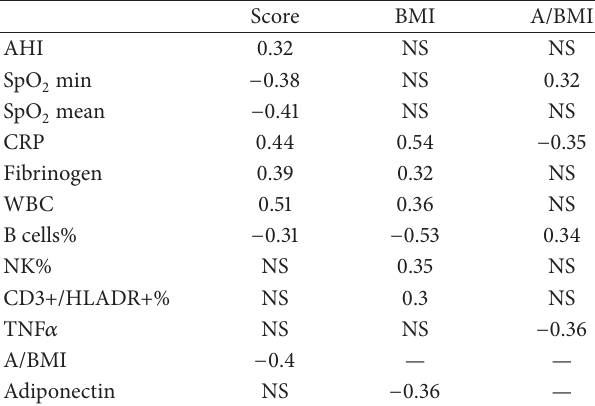
Table 4: Correlation of the indices of OSA severity, inflammatory markers, and selected lymphocyte subtypes with the index of OSA complication score and BMI (expressed as 𝑟 > 0.3 , significant 𝑝 < 0.05